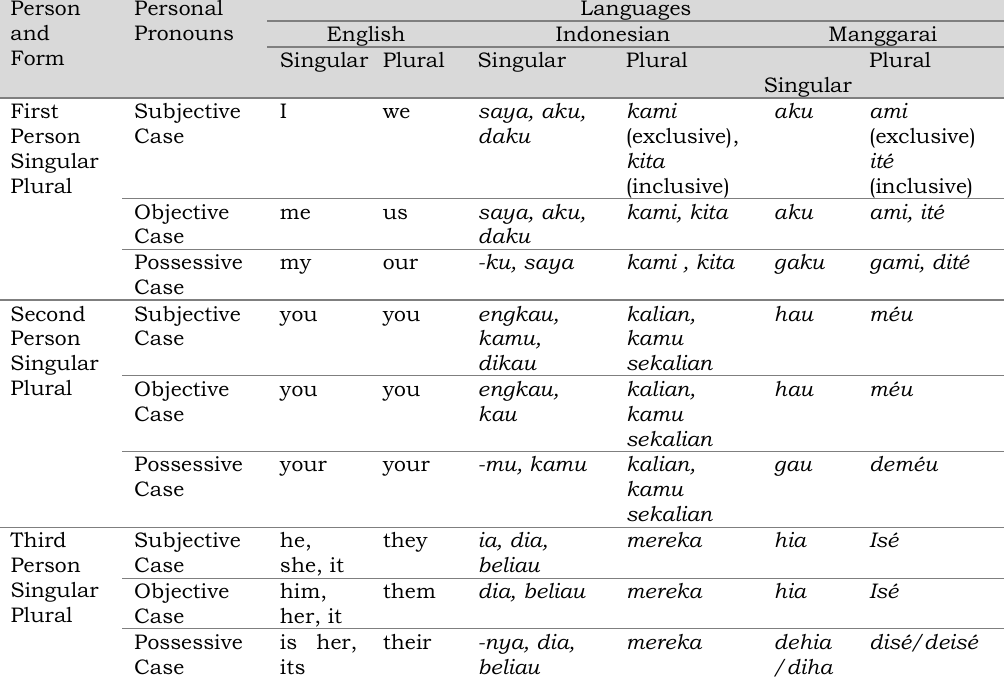
Table 4. The combining form of personal pronouns in three